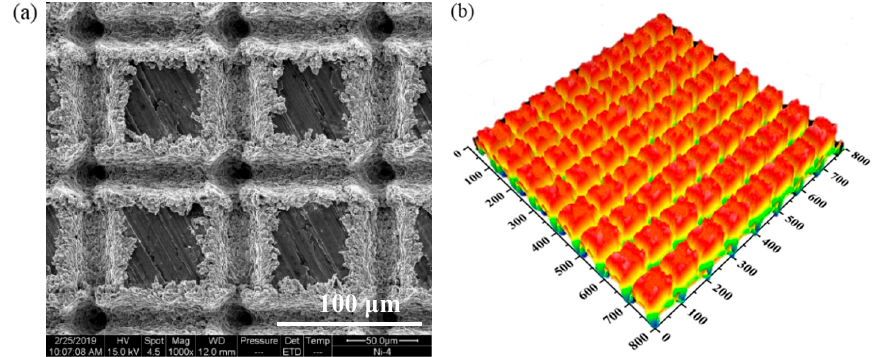
Figure 5. The surface morphology of the textured nickel ( a ) two-dimensional ( b ) three-dimensional.